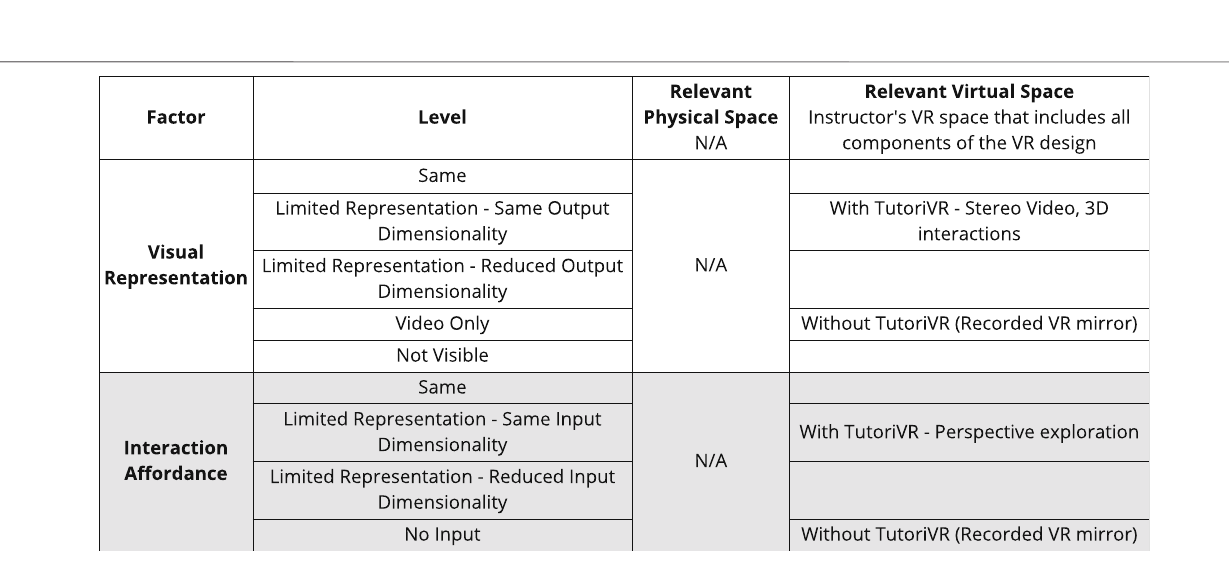
FIGURE 9 | Role of Interactive Mixed Dimensional Media in enhancing learning of VR tasks from 2D videos.